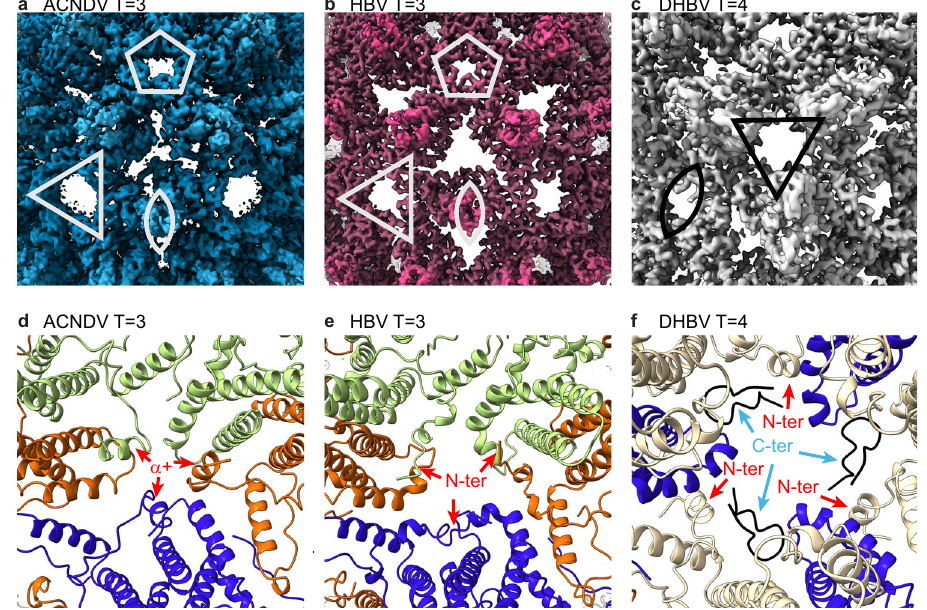
Fig. 6 | The N-terminus is different for ACNDV, HBV, and DHBV Cp. a Cryo-EM densitymap(3.7Å)oftheACNDVcapsidatpH7.5plottedatacontourlevelof4 σ . The center of the image shows the region between the fi vefold, threefold, and twofold axis where the additional α +helices partially occlude the triangular holes. Symmetry axes are marked with white symbols. b Cryo-EM density map of the T =3 HBV capsid from 29 (emd-20669) with a resolution of 3.5Å plotted at a contourlevelof4 σ .Thehole atthe localthreefold axis inthemiddle ofthe image is larger because HBV Cp lacks the α +helix. c Cryo-EM density map of the DHBV T =4 capsid (emd − 10800)with a resolutionof3.7Å 20 plottedata contour levelof